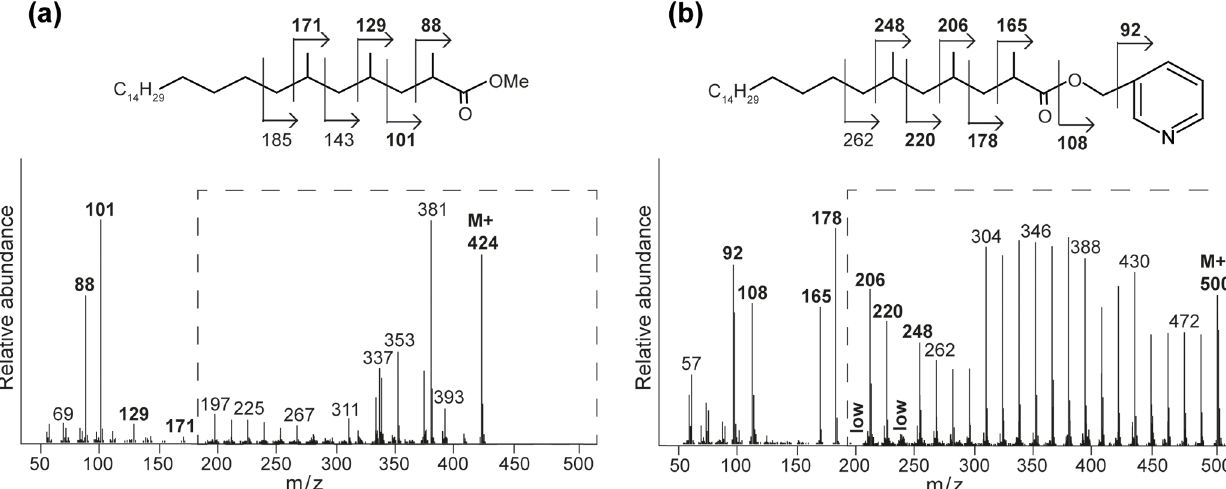
Figure 4. Mass spectra with fragmentation and annotated molecular structures of the (a) methyl ester and (b) picolinyl ester synthetic 2,4,6- trimethyl-tetracosanoic acid (C 27 2,4,6-Me MA standard). The dashed boxes show a 10 times exaggerated view into the indicated area of the mass